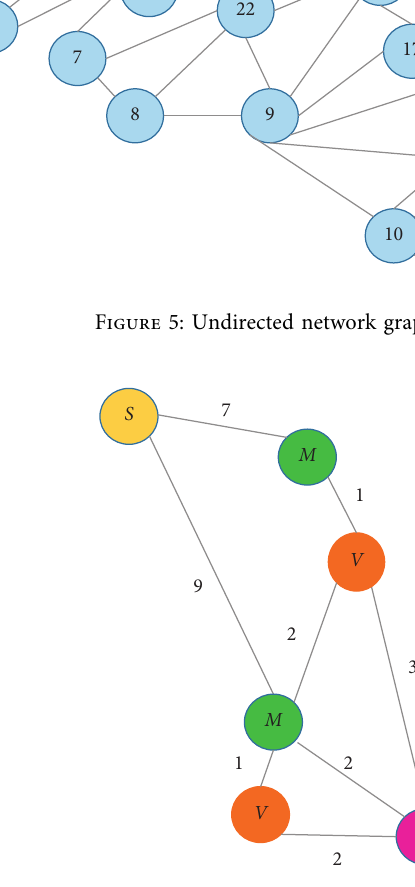
Figure 6: Undirected network graph 2.